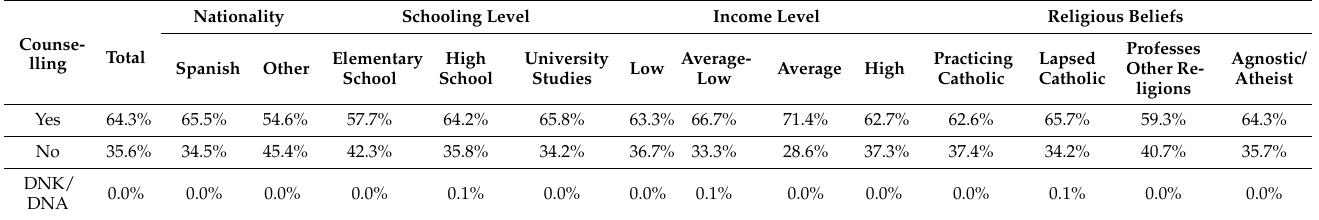
Table 3. Counselling on contraception over lifetime according to nationality, schooling and income levels and religious